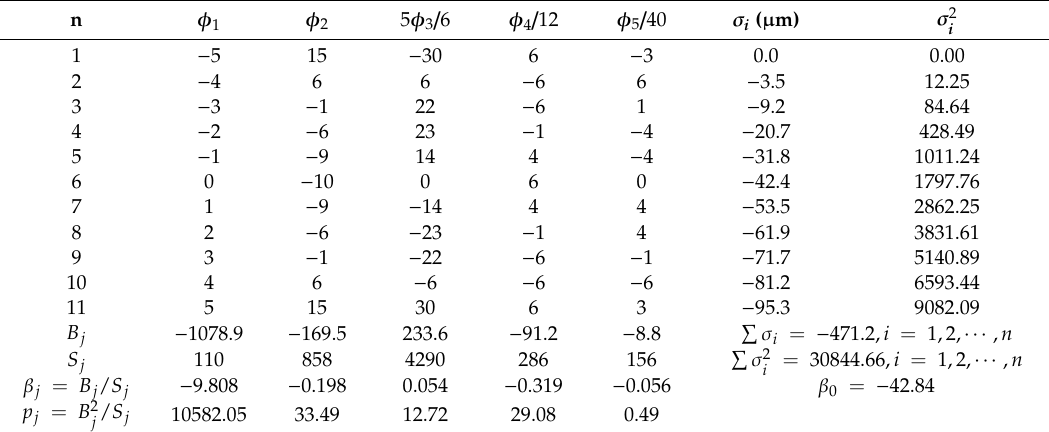
Table 6. Calculation of orthogonal polynomials.